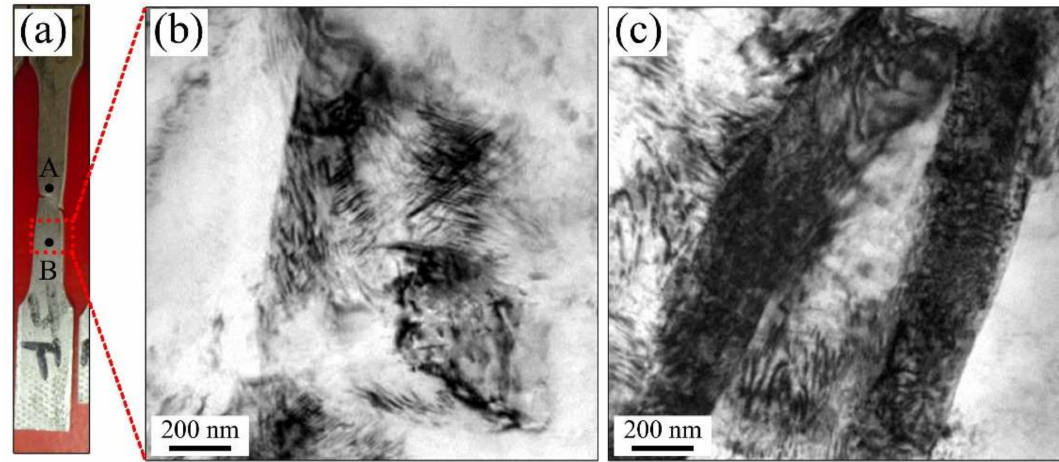
Figure 11. TEM characteristics of the necking part of the AZ31 magnesium alloy sheets after tension deformation: ( a ) tension sample; ( b ) dislocation pile-up; ( c )